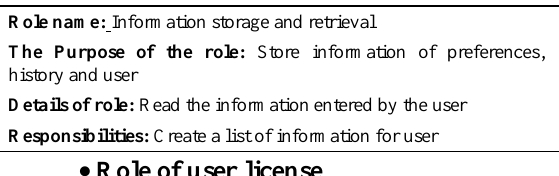
Table 8. Role model for the storage and retrieval of information.